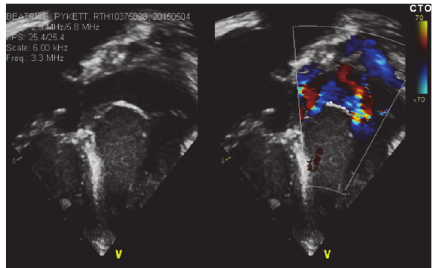
Figure 4: Postsurgical echocardiographic features of the proband: apical 4-chamber view demonstrating reduced mitral